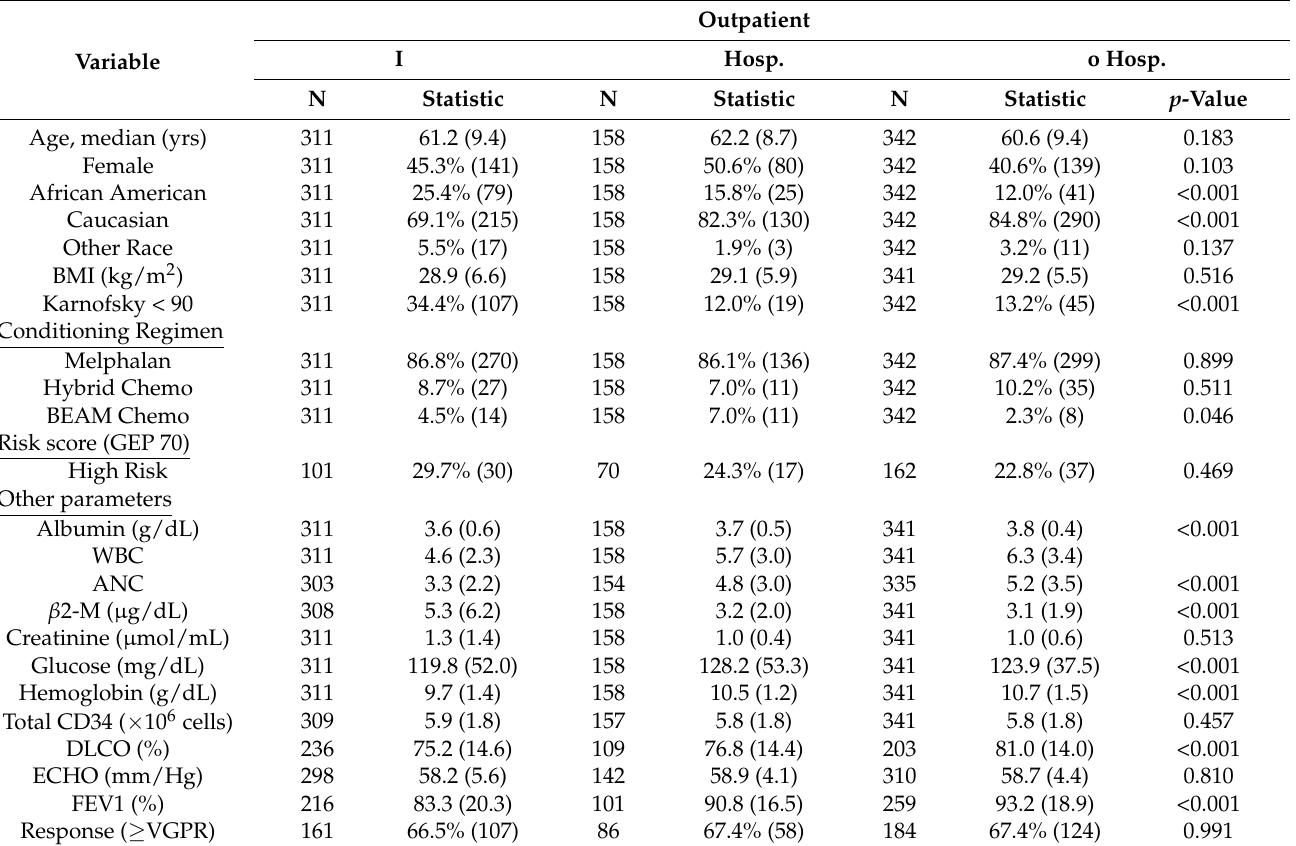
Table 1. Patient characteristics in first ASCT ( n = 811). BMI = body mass index, GEP70 = gene expres- sion 70 risk classifier, WBC = white blood count, ANC = absolute neutrophil count, DLCO = diffusion capacity for carbon monoxide, ECHO = echocardiogram, FEV1 = forced expiratory